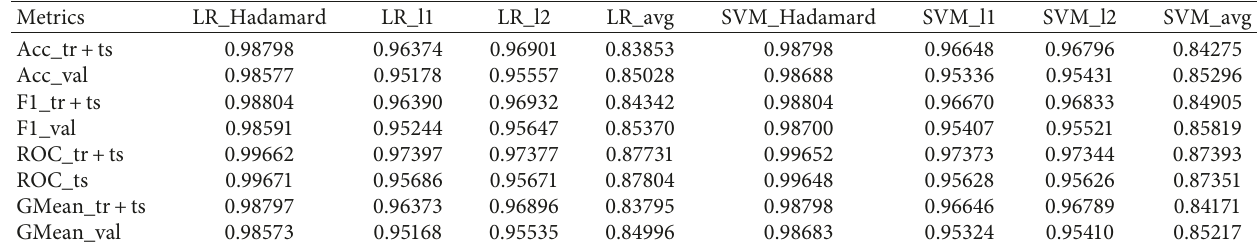
Table 14: For quoting interactions from April 12 until April 22 in 2021, utilizing the obtained embeddings through Node2Vec, performance of the LR and SVM models with operators Hadamard, l1, l2, and average 1,3 .